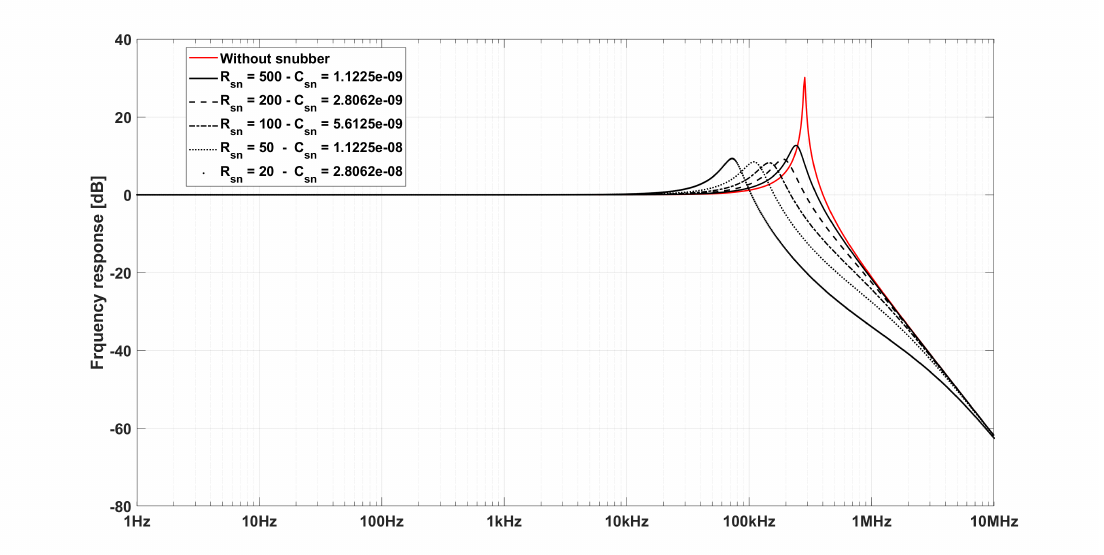
Figure 7. Frequency response of a coil-line system without any filter (red) and different snubber filter (black) with different R sn and C sn parameters for the same cut-off